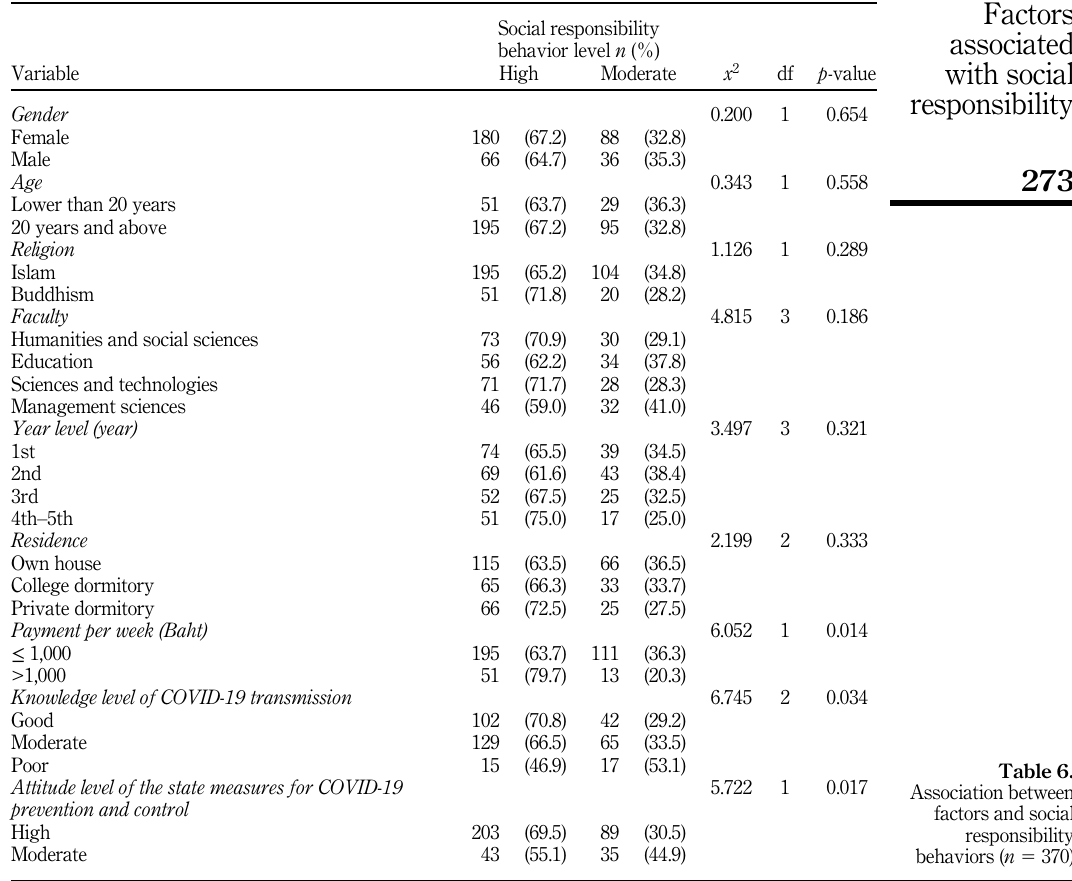
Table 6. Association